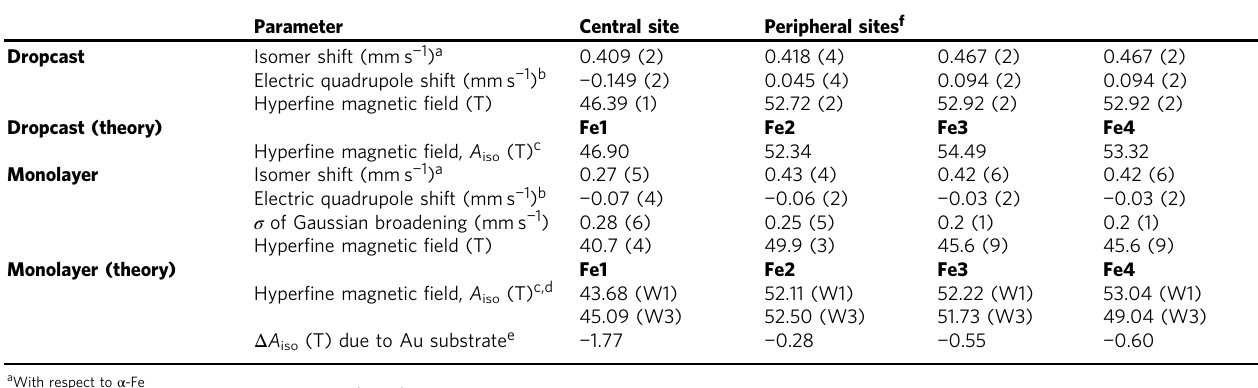
Table 1 Mössbauer parameters extracted from the fi tting of the spectra at T = 2.2 K and from ab initio calculations